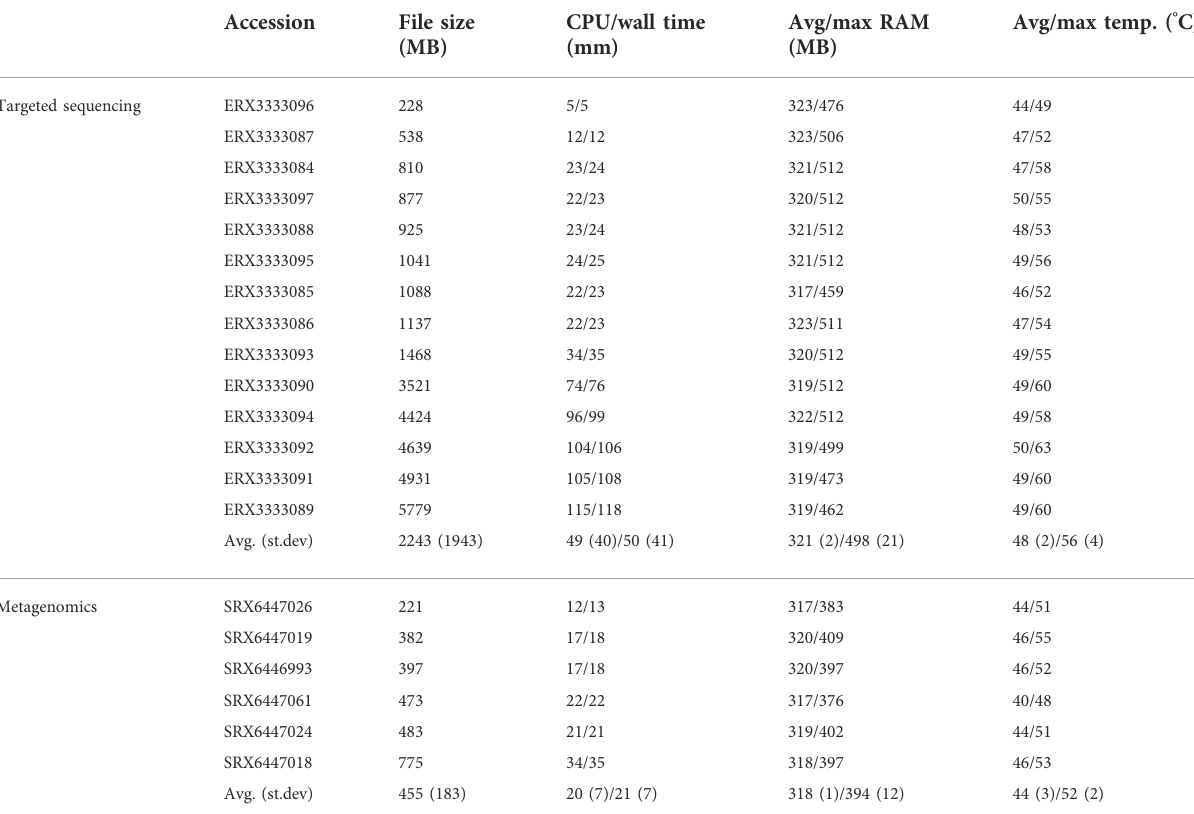
TABLE 2 Run summary of KARGAMobile on real experimental data: (1) targeted sequencing of C. cronae , C. freundii , and P. aeruginosa in hospital outbreaks; (2) metagenomics experiments from mechanically-ventilated patients hospitalized with severe